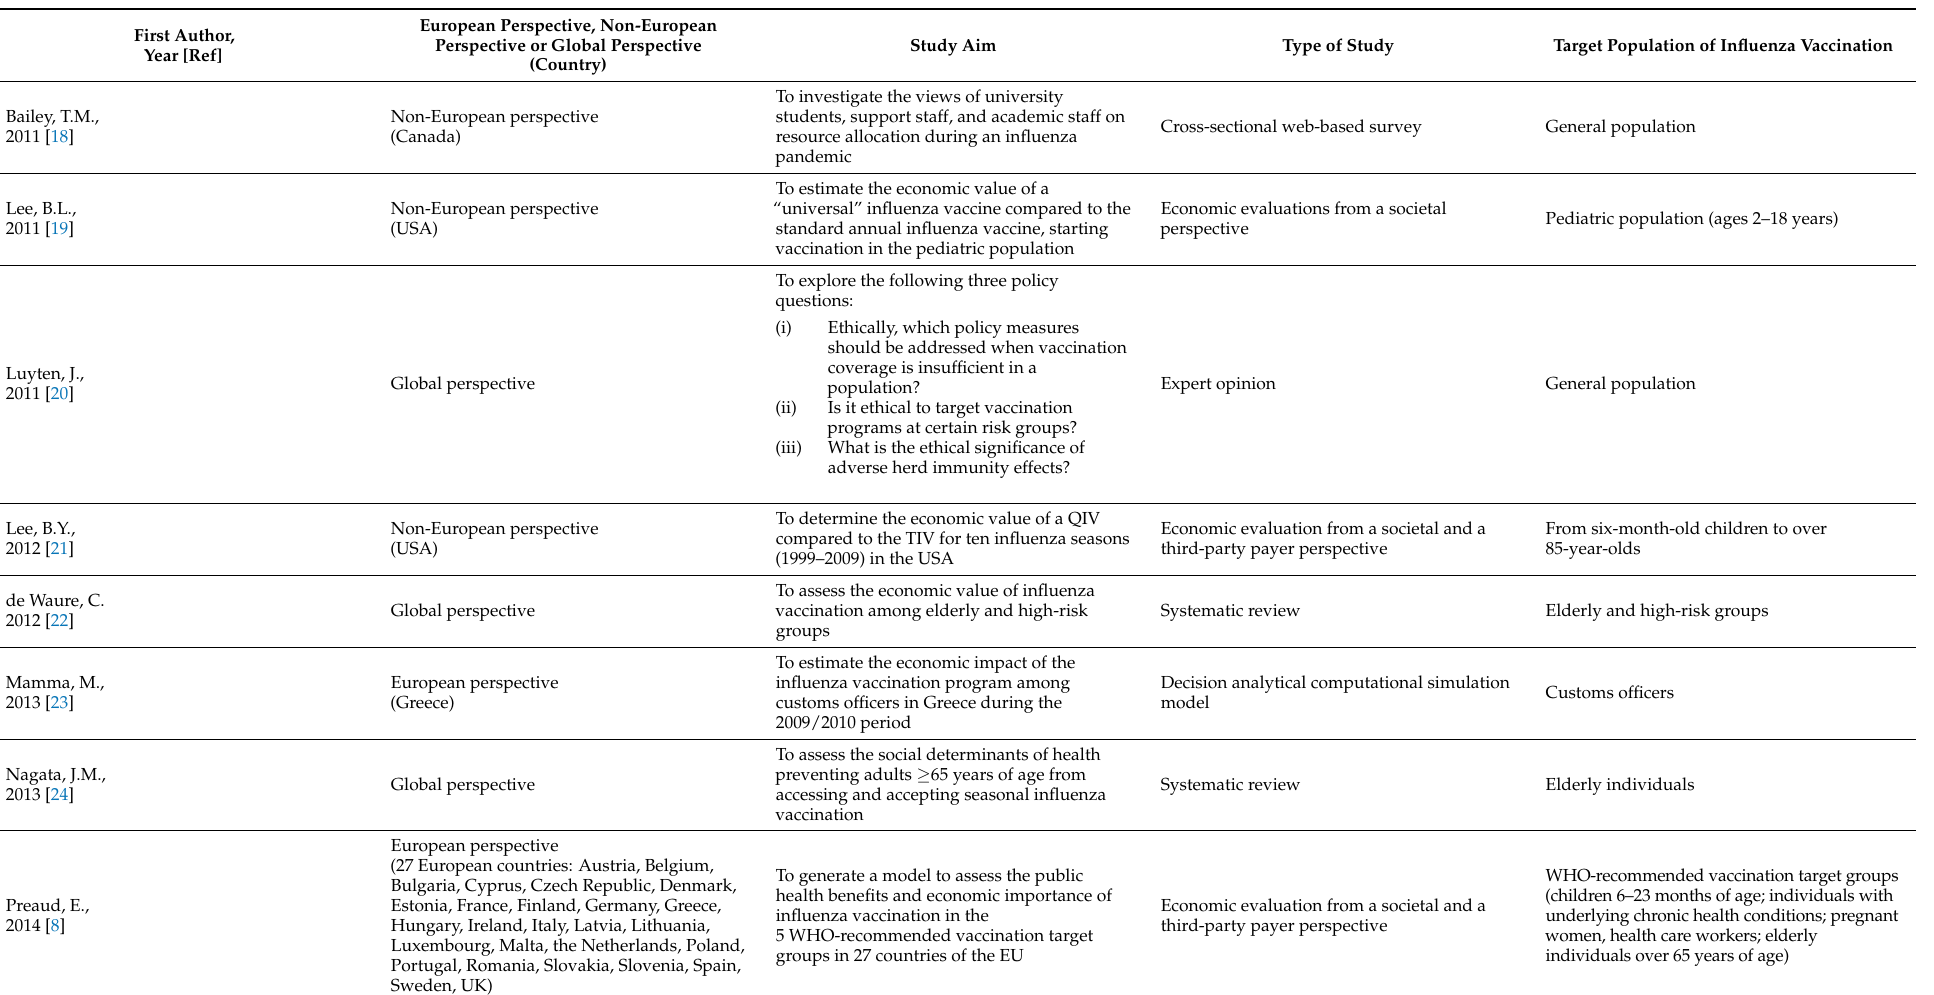
Table 1. Main characteristics of the included